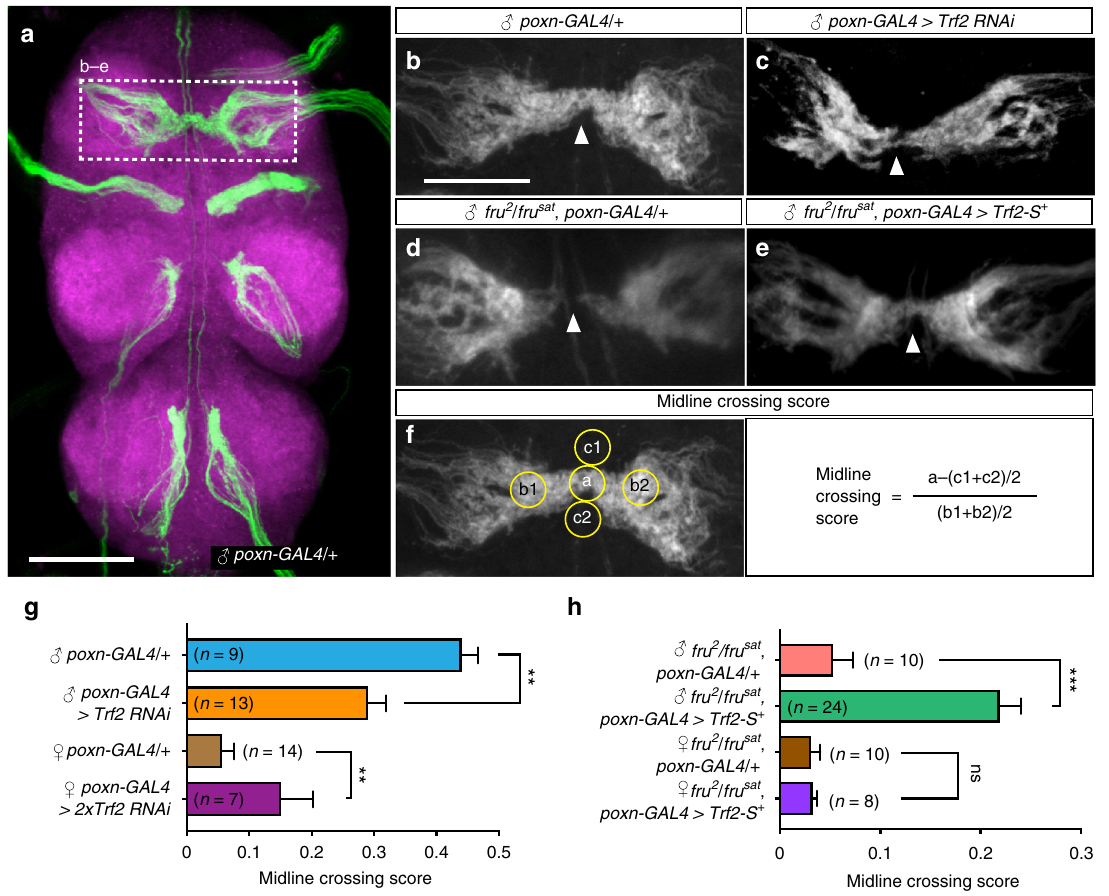
Fig. 3 Trf2 is required for the establishment of sexually dimorphic sensory innervation. a – e Sex-speci fi c sensory projections in the prothoracic ganglion. a The sensory projections stained for poxn-GAL4 -positive neurons in the entire ventral nerve cord of a male. Mellert et al. 36 reported that 96% of poxn - GAL4 - positive sensory cells in forelegs are fru -positive. The prothoracic segment is boxed with a broken line. b – e Enlarged views of prothoracic sensory projections in fl ies of the indicated genotype. Male-speci fi c midline crossing of sensory afferents (wild-type male: b ) was inhibited by Trf2 knockdown in poxn-GAL4 -expressing cells in a male fl y ( c ). The reduced level of midline crossing of sensory fi bers in the fru hypomorphic mutant male ( d ) was partially rescued by the overexpression of a wild-type Trf2-S transgene ( Trf2-S + ) ( e ). f The regions examined when quantifying the fl uorescent intensity to estimate the level of midline crossing of sensory fi bers. For more details, see the main text and Methods. g , h Quantitative comparisons of the midline crossing score between fl ies with and without Trf2 knockdown ( g ) and those with and without Trf2-S + overexpression ( h ) in males and females. Statistical differences were evaluated by Student ’ s t test. *** P < 0.001, ** P < 0.01; ns not signi fi cant. Error bars indicate SEM. Scale bars: 100 µ m ( a ), 50 µ m ( b fl uorescent intensity measured at the midline relative to that at “ blank ” regions where no sensory fi bers run (Fig. 3f). This analysis revealed that the MCS was signi fi cantly decreased in males by Trf2 knockdown as directed by poxn-GAL4 , a driver for gustatory receptor neurons (Fig. 3a – c, g). Conversely, Trf2 knockdown in females increased the midline crossing (Fig. 3g), suggesting the feminizing ability of Trf2 in the absence of FruBM.